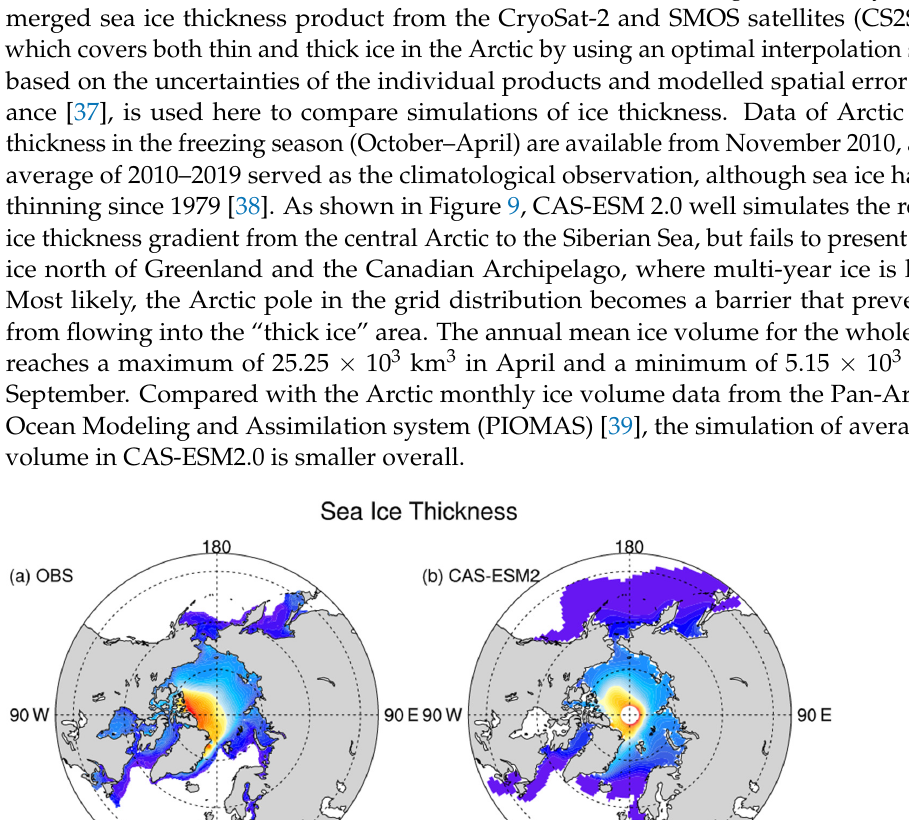
Figure 9. Average ice thickness during freezing season from ( a ) CS2SMOS observations during 2010 − 2019 and ( b ) CAS-ESM 2.0 for ensemble mean of 1979 − 2014 historical simulation in the Northern Hemisphere, and ( c ) simulated average ice volume in the Arctic during 1979 − 2014. Despite the grid issues, CAS-ESM 2.0 successfully captures the two primary com- ponents of Arctic sea ice motion, the Beaufort Gyre by an anticyclonic regime and the polar transport stream by ice moving from the Siberian coast of Russia across the Arctic basin into the Greenland Sea (Figure 10a,b). The large-scale clockwise circulation of ice around Antarctica is also presented in the simulations, with northward movement on average and gyres in the Ross Sea and small rotation in the Weddell Sea (Figure 10c,d).